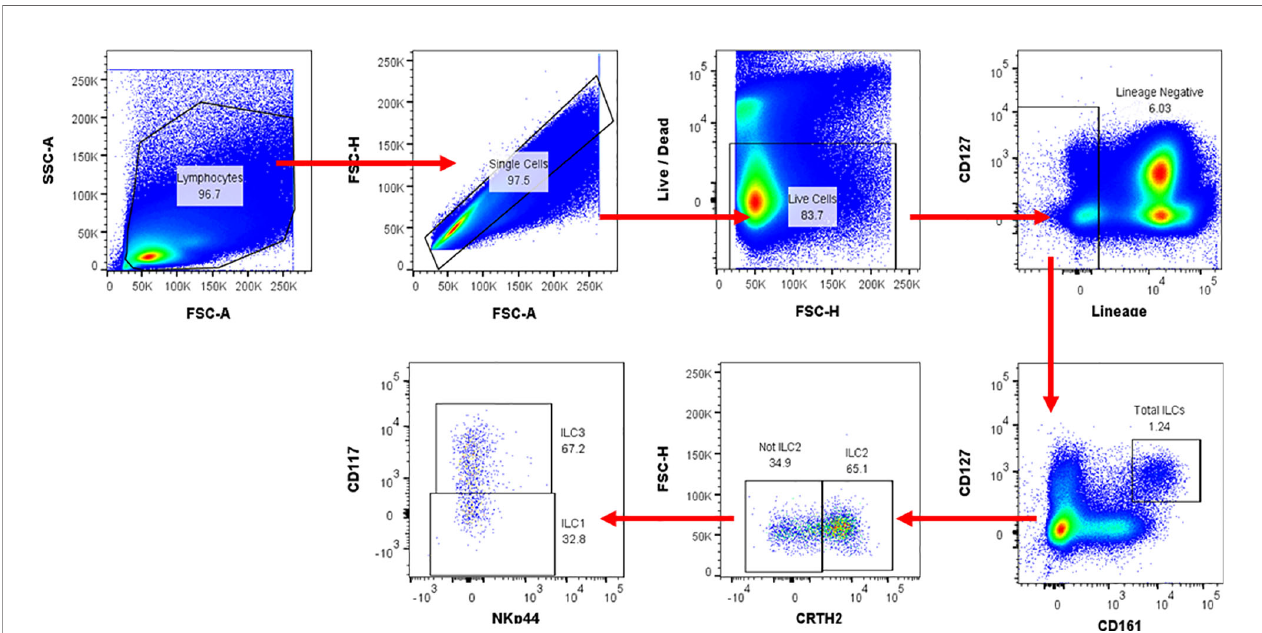
FIGURE 1 | Flow cytometry gating strategy used for ILC identi fi cation and cytokine production in human peripheral blood. Representative fl ow cytometric plots for ILCs in peripheral blood. Numbers in gates (outlined areas) indicate the per cent cell in each. After gating on the time gate, lymphocytes and single cells, distinct ILC populations were de fi ned as: total ILCs (Lin [CD3/CD14/CD16/CD19/CD20/CD56] − CD127 + CD161 + ); ILC1 (Lin − CD127 + CD161 + CRTH2 - CD117 − ); ILC2 (Lin − CD127 + CD161 + CRTH2 + ); ILC3 (Lin − CD127 + CD161 + CRTH2 + NKp44 +/ − CD117 + ). The cytokine expression levels for IL-13 and IFN- g were evaluated using intracellular cytokine staining. FSC-A, Forward scatter-area; FSC-H, Forward scatter-height; SSC-A, Side scatter-area.